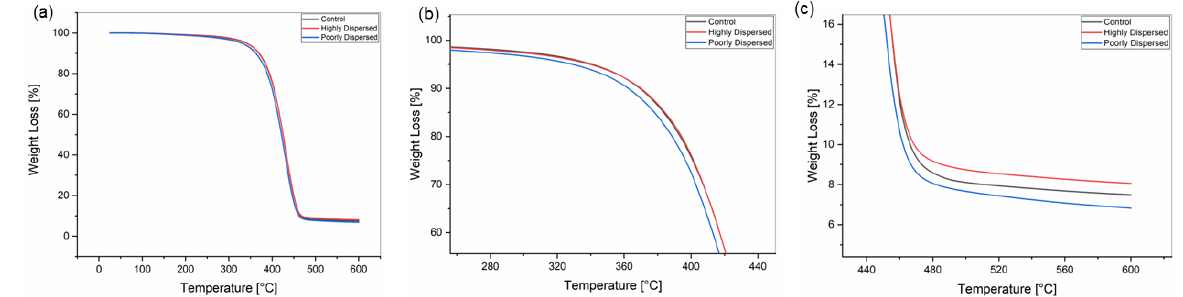
Figure 10. TGA curves of control and highly and poorly dispersed GO nanocomposites. ( a ) TGA curves of highly dispersed, poorly dispersed, and control specimens. ( b ) Magnification of the upper area. ( c ) Magnification of the lower area.